Question: Give a one-sentence summary of this figure.
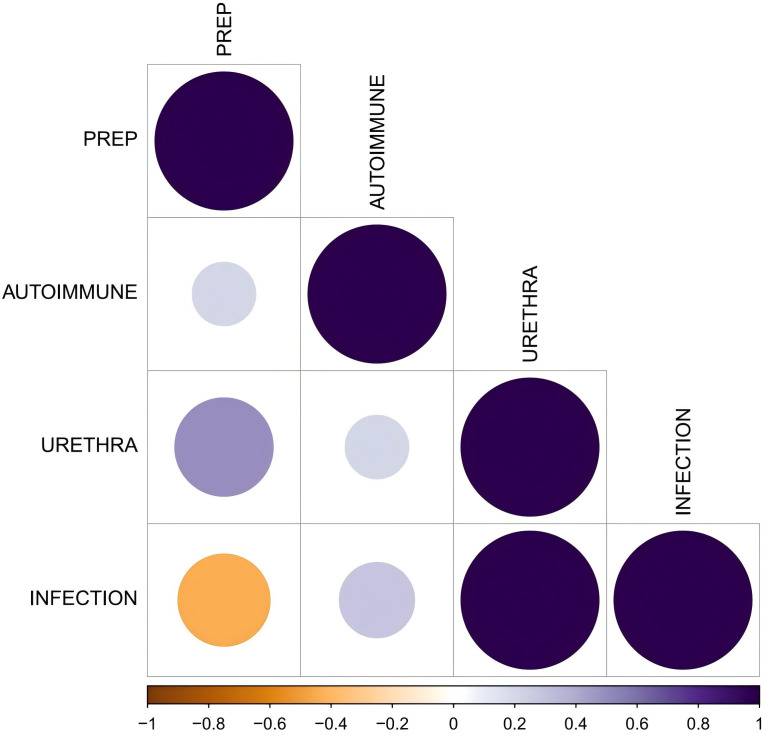
Answer: MGLSc genetic correlation matrix. The color intensity and the size of the circles are proportional to the strength of the correlation.